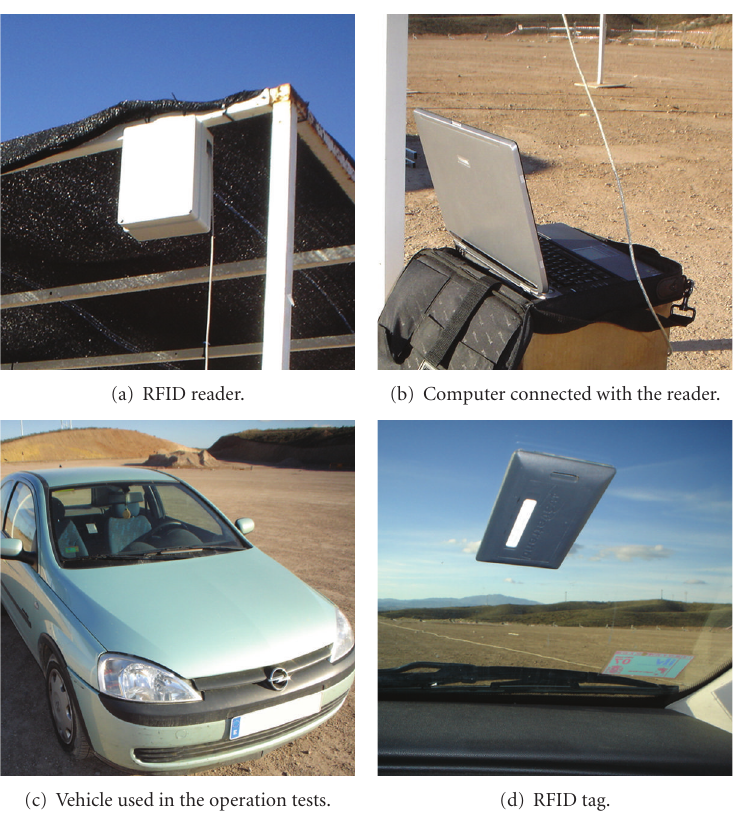
Figure 4: Hardware set-up of the RFID identification